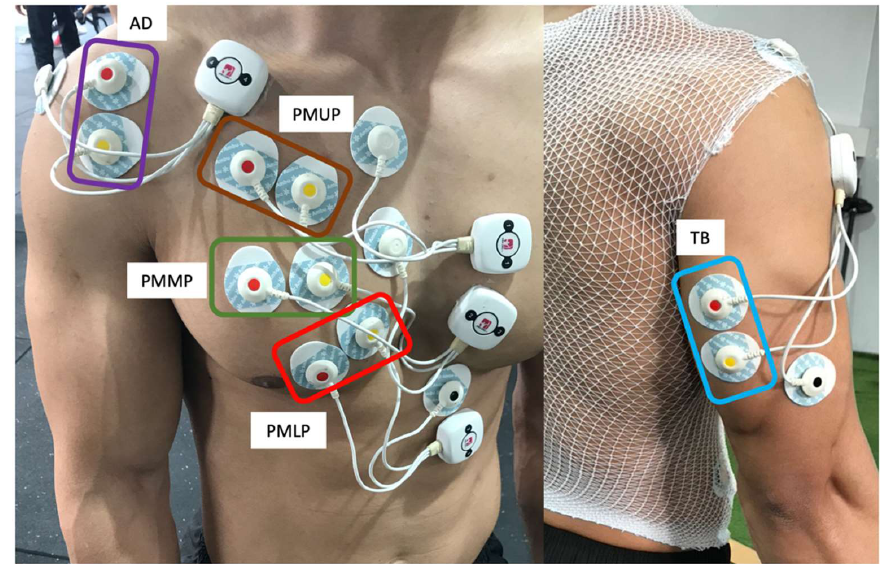
Figure 1. Electrode placement diagram for recording electromyographic (EMG) activity. AD: anterior deltoid; PMUP: pectoralis major upper portion, clavicular portion; PMMP: pectoralis major middle portion, sternal portion; PMLP: pectoralis major lower portion, costal portion; TB: triceps brachii, medial head.